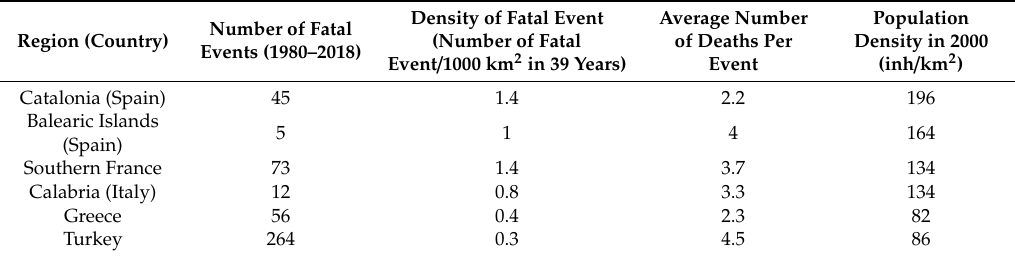
Table 4. Density of fatal event per region.